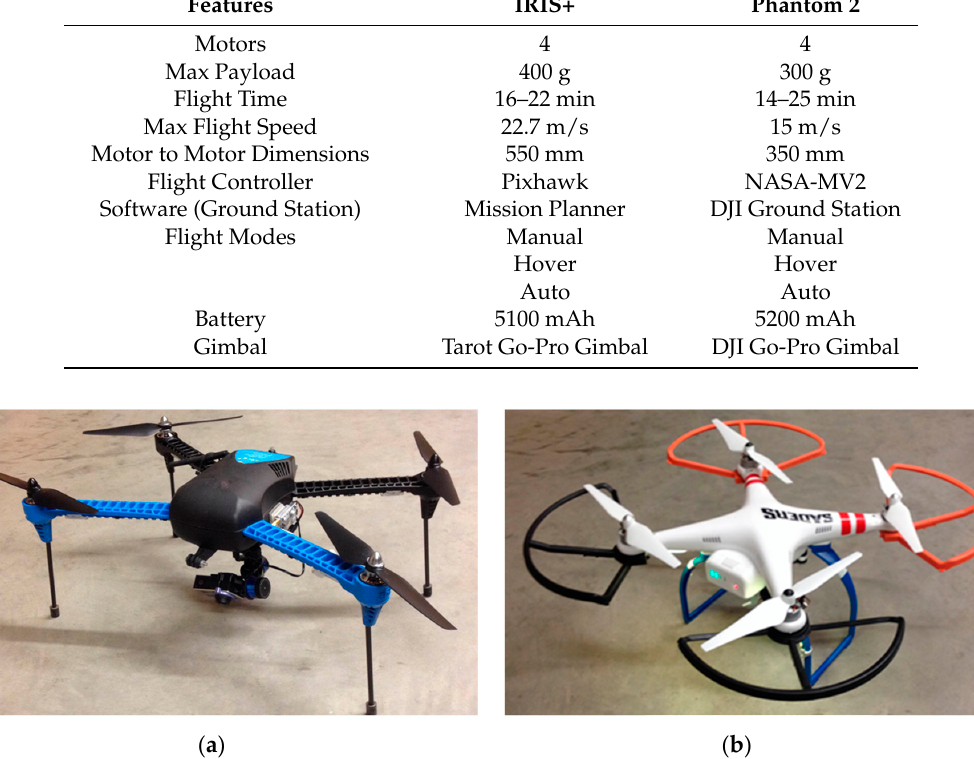
Figure 1. 3DR Iris+ and DJI Phantom 2 quadcopter drones. ( a ) 3DR Iris+; ( b ) DJI Phantom 2.